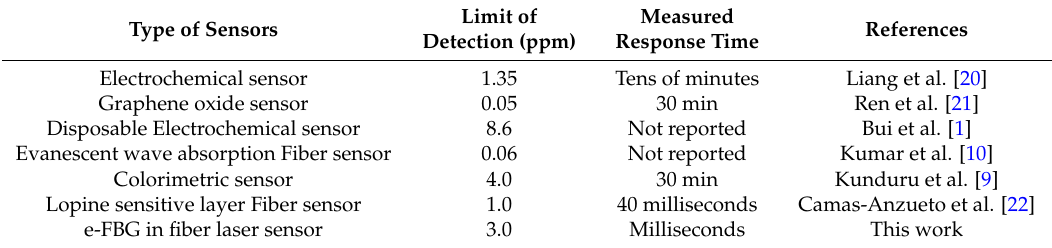
Table 1. Comparison of nitrate-in-water detection limits and response times using different